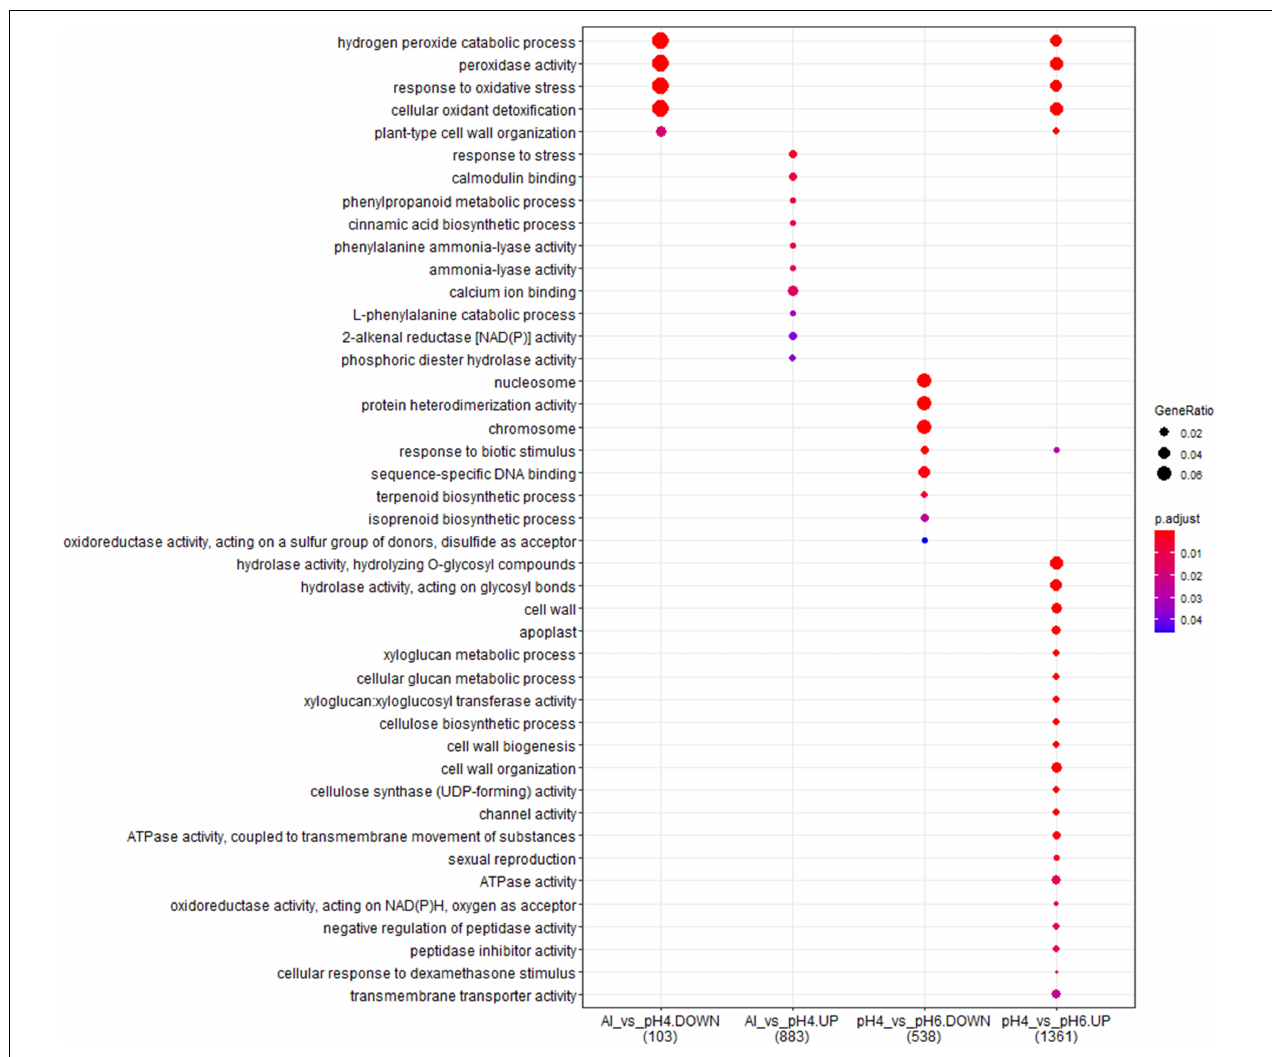
FIGURE 12 | The comparison of GO terms over-representation analysis of differentially expressed genes in the short-term experiment using hypergeometric test under α = 0.05 with FDR adjusted P